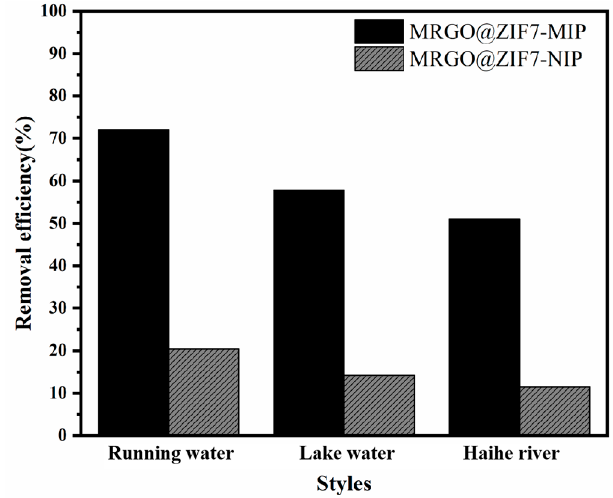
Figure 10. Adsorption of MRGO@ZIF7-MIP for BPA in “simulated” wastewater. Other conditions: 10 mg sorbent, 10 mL “simulated” wastewater of 0.08 mmol L − 1 BPA, temperature 25 °C.